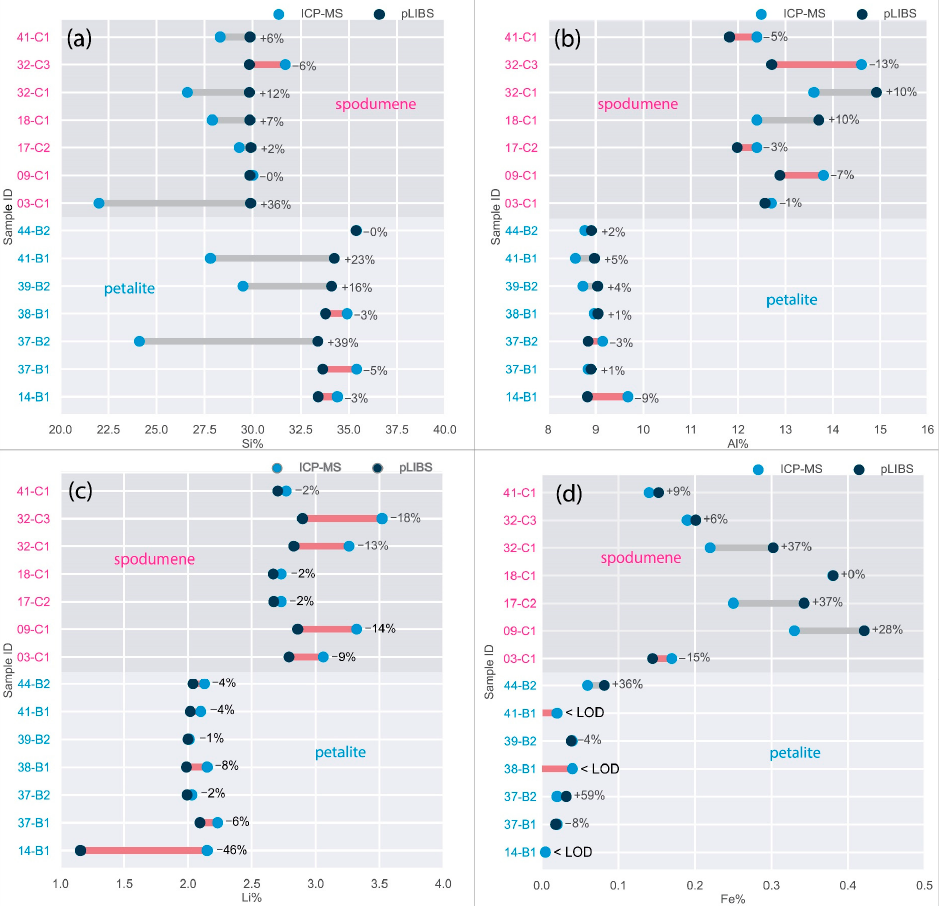
Figure 23. Percentage of the errors of the pLIBS compared to the ICP-MS results for ( a ) Al, ( b ) Si, ( c ) Li and ( d ) Fe with the Spd_Barroso calibration and Pet_Barroso calibration. LOD (Limit of Detection). The Spd_Barroso and the Pet_Barroso calibration were also tested in seven di ff erent potassium feldspars to evaluate if samples without Li could be giving false positives while using these two calibrations. As can be seen in Figure 24, Figure 25 and Figure 26, the Li results were always very low (<0.8% Li). Therefore, even if a K-feldspar is analyzed by